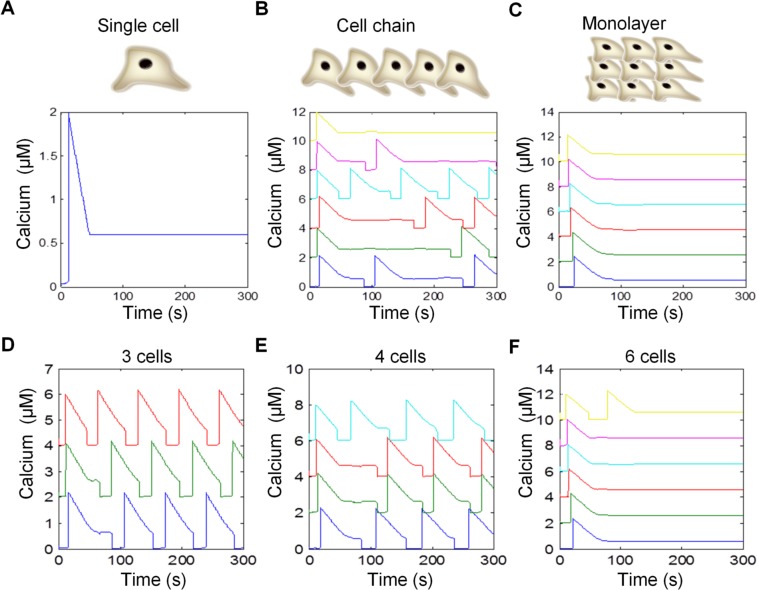
Computational modeling of architecture-dependent calcium signaling.(A–C) Effects of cellular architectures on calcium signaling in (A) a single cell, (B) 9 cells connected linearly as a chain with periodic boundary conditions, and (C) 9 cells connected in a monolayer with periodic boundary conditions. The calcium dynamics of six cells were shown for clarity. (D–F) Calcium dynamics for (D) 3, (E) 4, and (F) 6 coupled cells. The data were shifted vertically for clarity.